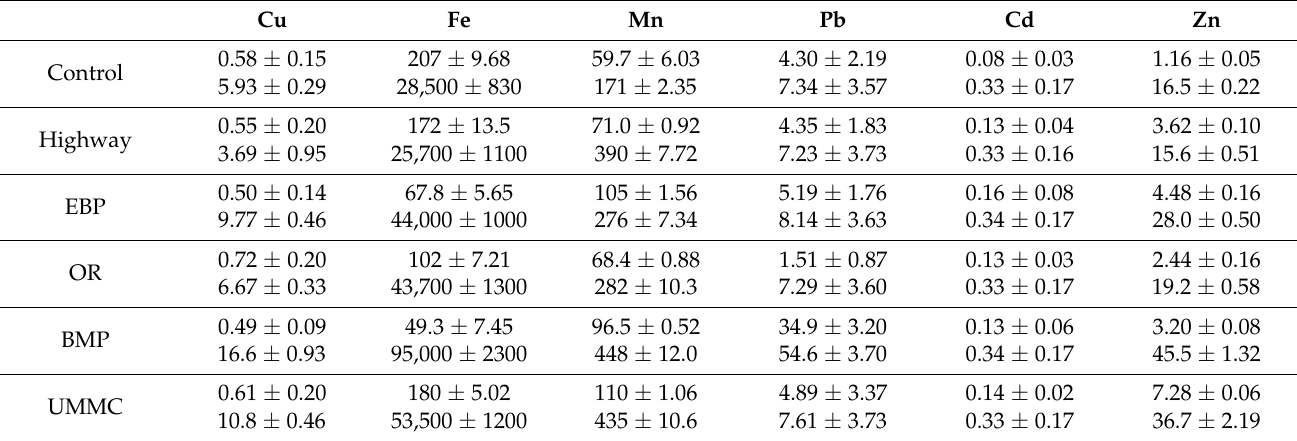
Table 3. Heavy metal concentrations (mg kg − 1 mean ± 95% confidence interval) in soils in Tyumen in 2019 (above the line—mobile forms; below the line—acid-soluble forms).